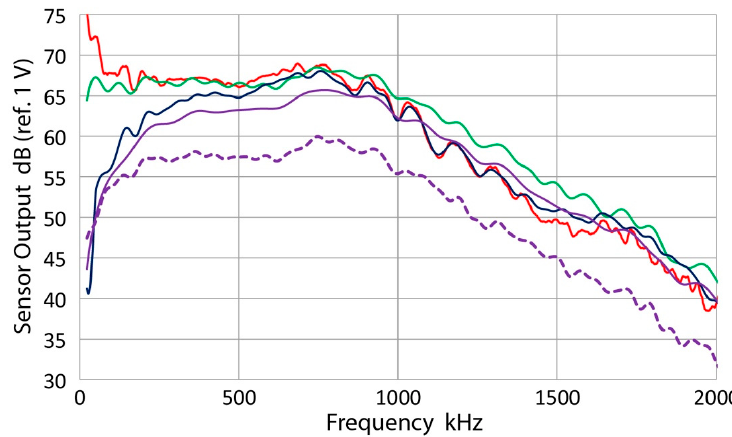
Figure A10. Output spectra from KRN sensor (#12060) excited by Olympus V192 using various input parameters. Red: FET buffer with R in = 1 M Ω , Green: direct oscilloscope input with R in = 1 M Ω /C = 14 pF, Blue: FET buffer with R in = 10 k Ω , Purple: direct oscilloscope input with R in = 100 k Ω /C = 14 pF, Purple dash: cable connection with R in = 10 k Ω /C = 86 pF.